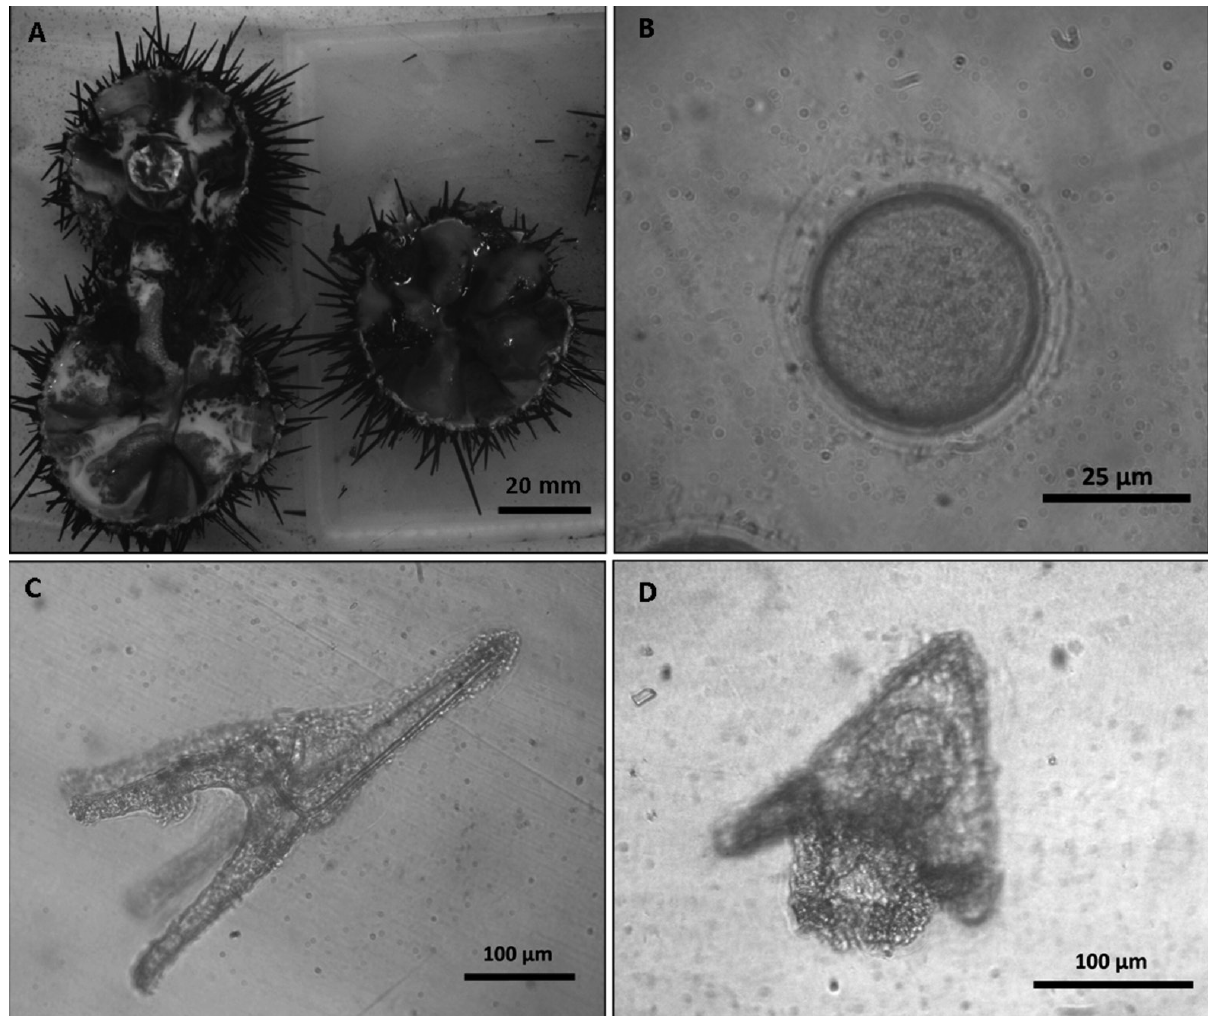
Fig. 2. – Paracentrotus lividus bioassay. A, equatorial dissection of the sea urchin before fertilization; B, oocyte with the fertilization mem- brane after fertilization; C, sea urchin larva completely developed with the four arms correctly separate; D, poorly developed sea urchin larva resulting after exposure to toxic